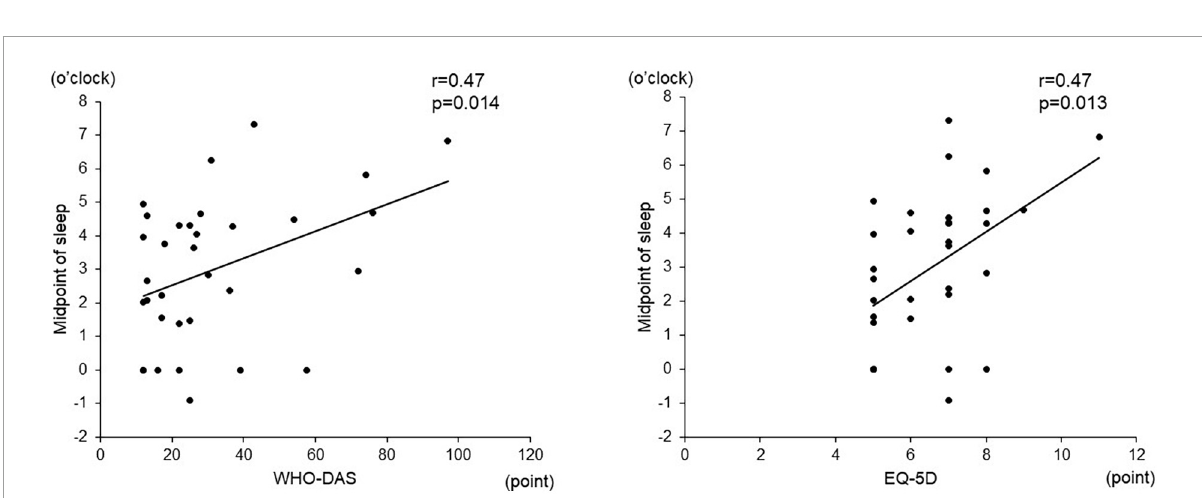
FIGURE4 Correlation between the midpoint of sleep and WHO-DAS and EQD scores. The midpoint of sleep shows a significant correlation with the WHO-DAS ( r = 0.47, p = 0.014) and EQ5D scores ( r = 0.47, p = 0.013). WHO-DAS: World Health Organization Disability Assessment Schedule, EQ5D: Euro QOL 5